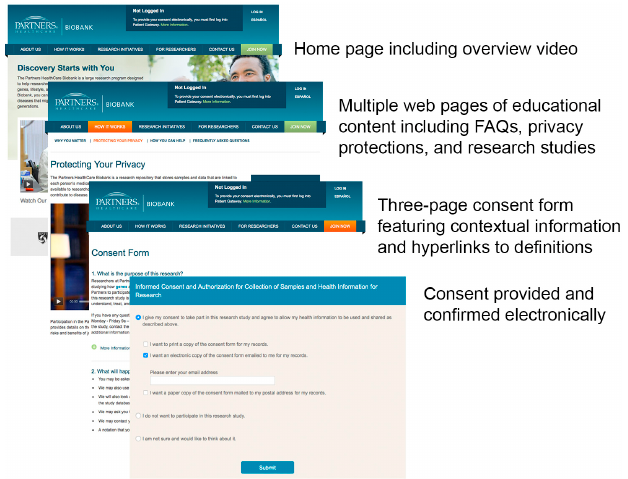
Figure 1. Screenshots from the Biobank eIC website, illustrating key components of the eIC presentation, (Illustration of eIC design).